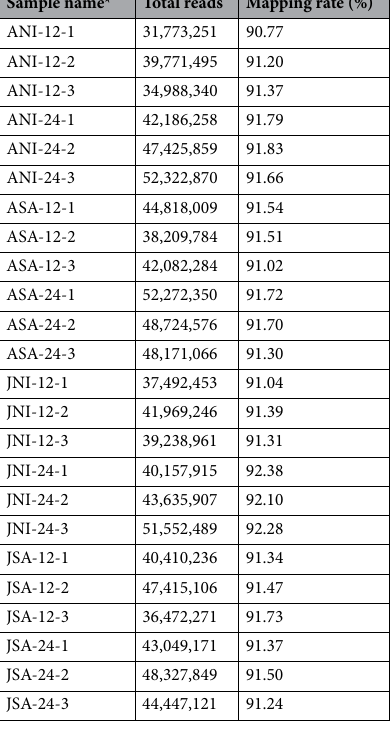
Table 1. RNA sequencing read numbers and mapping rate to M. truncatula. * A, A17; J, Jester; NI, non infested; SA, SAA infested; 12, after 12 h infestation; 24, after 24 h infestation; -1/-2/-3, number of biological repeat.